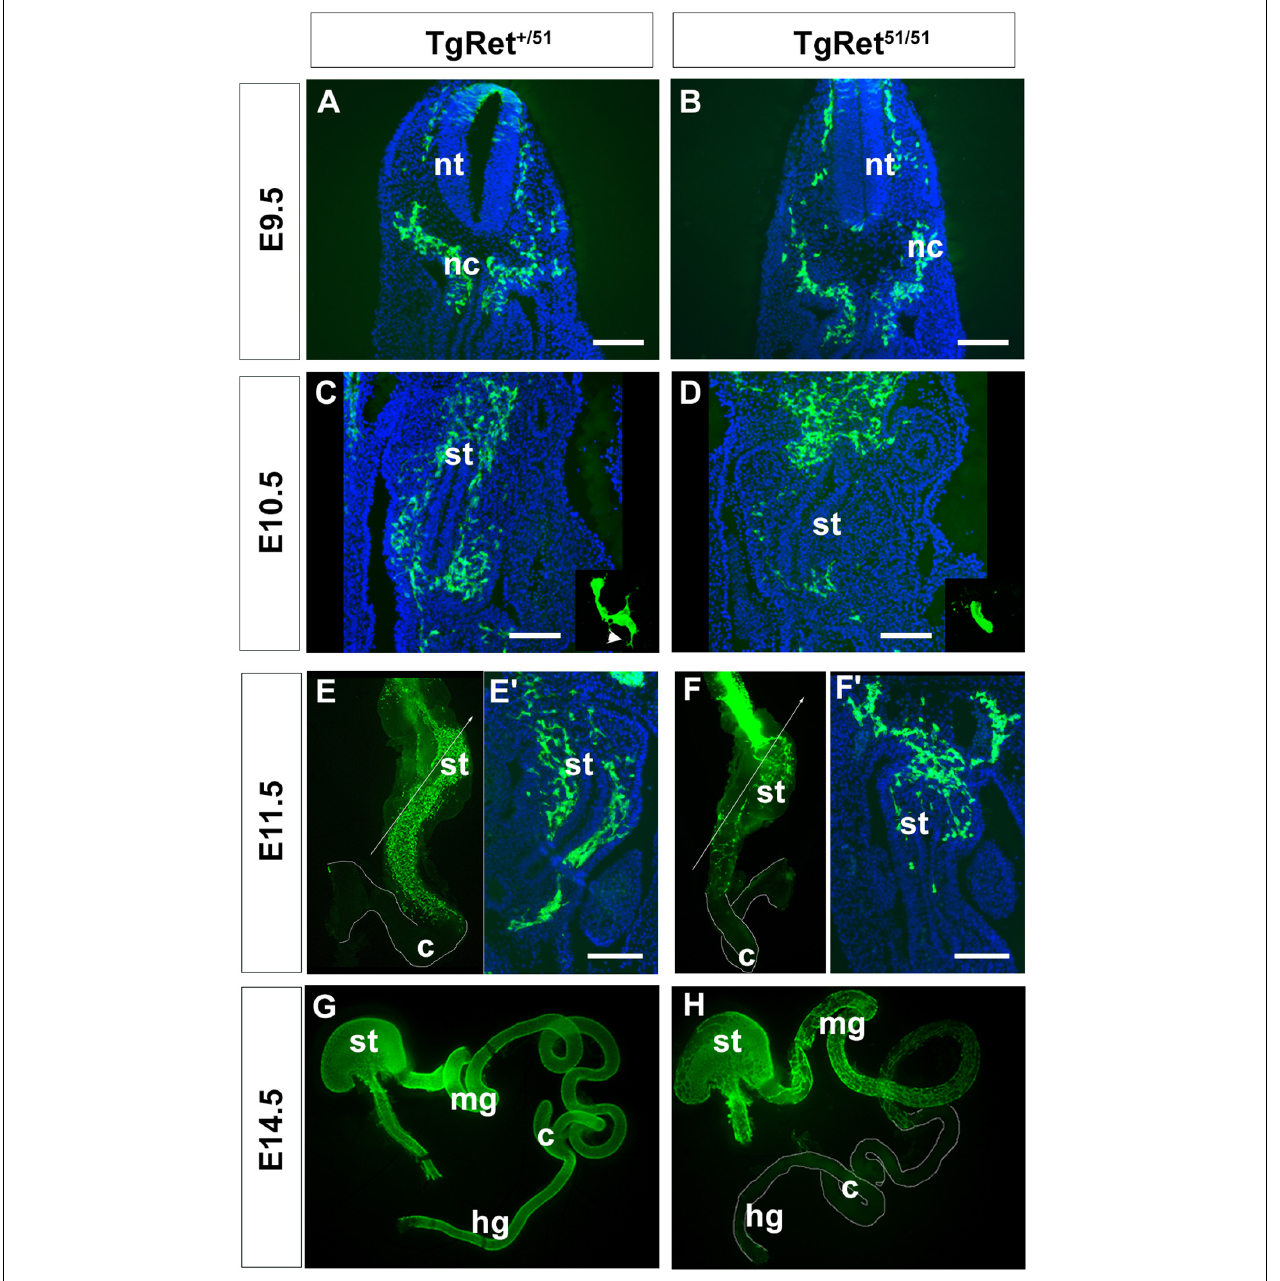
FIGURE 1 | Delayed migration of ENS progenitors along the gut of Ret 51 / 51 mutant embryos. (A,B) Immunostaining of representative cryosections through the foregut of control (Tg Ret + / 51 ) and Tg Ret 51 / 51 E9.5 embryos with GFP-specific antibodies. At this stage no difference was detected in the distribution of GFP-labelled vagal neural crest cells (nc) and pENCCs between control and mutant embryos. (C,D) GFP immunostaining of sections through the foregut of E10.5 control (Tg Ret + / 51 ) and Tg Ret 51 / 51 embryos. In control (Tg Ret + / 51 ) embryos, ENCCS are distributed throughout the foregut mesenchyme but in Tg Ret 51 / 51 mutants they fail to migrate much beyond the gastroesophageal junction. Insets show high power images of isolated GFP + cells from control (Tg Ret + / 51 ) and mutant embryos, respectively. Arrowhead in inset (C) shows projections in control ENCC. (E,F) Whole mount preparations of gut dissected from control (Tg Ret + / 51 ) and Tg Ret 51 / 51 E11.5 embryos, immunostained for GFP showing that migration of Tg Ret 51 / 51 ENCCs is delayed relative to control Tg Ret + / 51 cells. (E’,F’) Sections through the foregut of control Tg Ret + / 51 and Tg Ret 51 / 51 embryos that correspond to the lines shown respectively in (E,F) . (G,H) Whole mount preparations of gut dissected from control Tg Ret + / 51 and Tg Ret 51 / 51 E14.5 embryos immunostained for GFP. Control ENS progenitors have colonized the entire gut but Ret 51 / 51 progenitors have colonized only the foregut and the proximal half of the small intestine. Embryos from 3 litters per stage were used (approximately 4–6 per genotype). The embryos were isolated, genotyped individually and analyzed separately using immunolabelling. Scale bar: 200 µ m. nc, neural crest; nt, neural tube; st, stomach; mg, midgut; c, caecum; hg, hindgut. Tg Ret + / 51 represents cells or embryos from genotype Wnt1 cre / + ;R26R stop / YFP ;Ret + / 51 and Tg Ret 51 / 51 represents cells or embryos from genotype Wnt1 cre / + ;R26R stop / YFP ;Ret 51 / 51 .